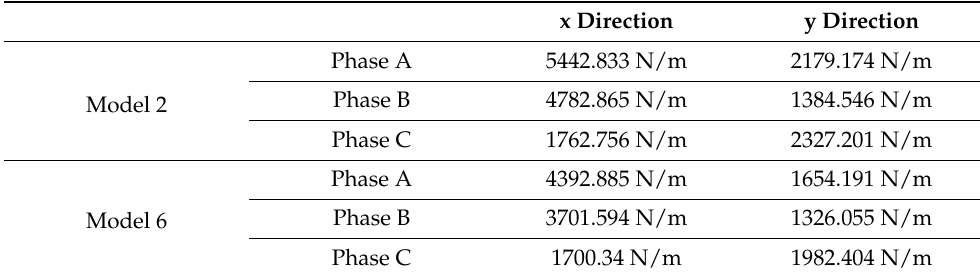
Table 10. Maximal absolute value of electrodynamic forces per phase at 60 Hz.